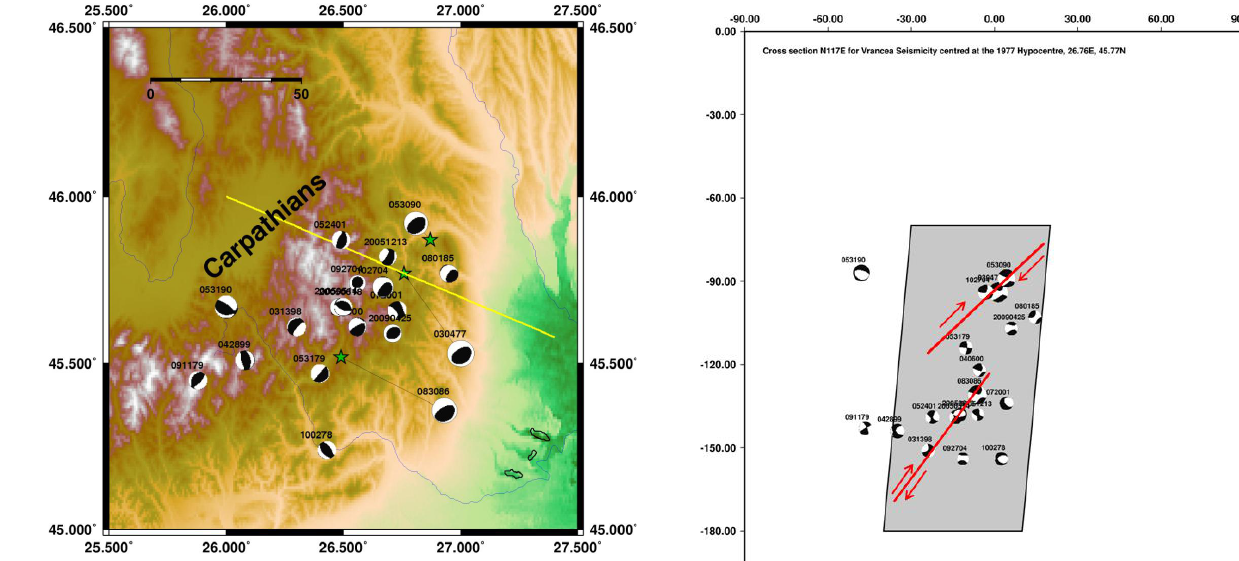
Fig. 8. Map of south Carpathian region (Romania) showing fo- cal mechanisms of intermediate-depth earthquakes from the global CMT database using a lower-hemisphere stereographic projection. The date of each event is written above each sphere. Black colour indicates compressional quadrant. The fault plane responsible for each earthquake will be parallel to one of the nodal planes. Green stars are epicenters of the 1977, 1986 and 1990 earthquakes. Yel- low line shows the vertical cross-section of Fig. 8 (the line passes through the 1977 epicentre which is the first event of the sequence that we investigate in this paper). The line is 104km long and the azimuth is N117 ◦ E.